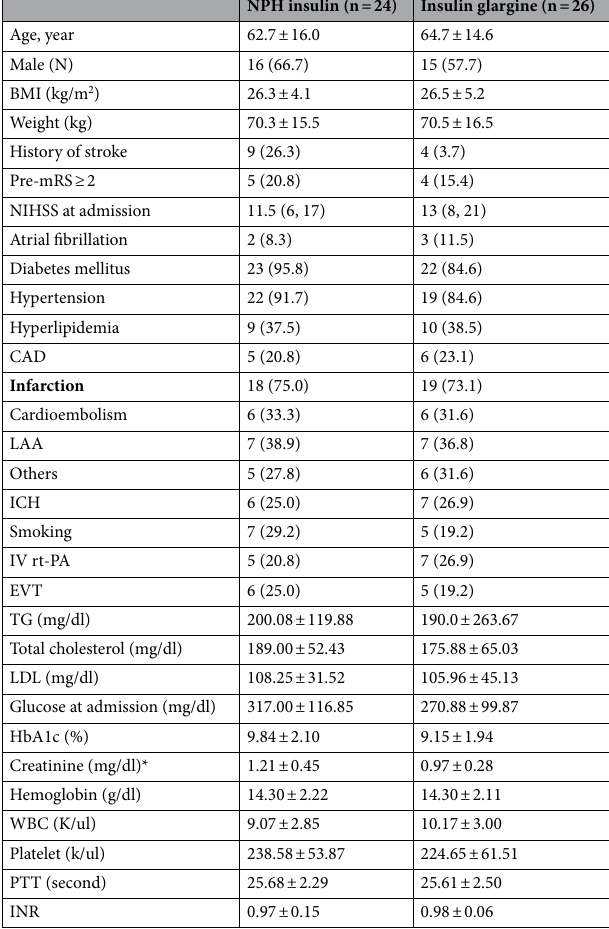
Table 1. The baseline characteristics of AIS patients. Data was expressed as number (proportion) or mean ± standard deviation. NPH neutral protamine hagedorn insulin, BMI body mass index, mRS modified Rankin Scale, NIHSS National Institute of Health Stroke Scale, CAD coronary artery disease, LAA large artery atherosclerosis; Others include other determined and undetermined. ICH intracerebral hemorrhage, IV intravenous, EVT endovascular thrombectomy, WBC white blood cell, PTT partial thromboplastin time, INR international normalized ratio, TG triglyceride, LDL low-density lipoprotein, HbA1c glycated hemoglobin. *Creatinine (mg/dl) is the only one baseline parameter with significant difference between these two